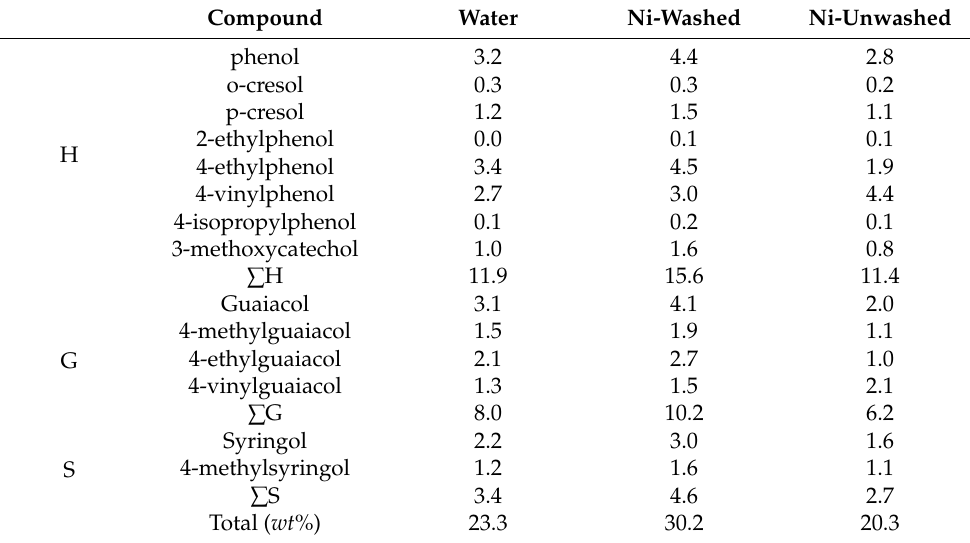
Table 4. Yields of Small-Molecule compounds (on the basis of the weight of bio-oil) ( wt.%